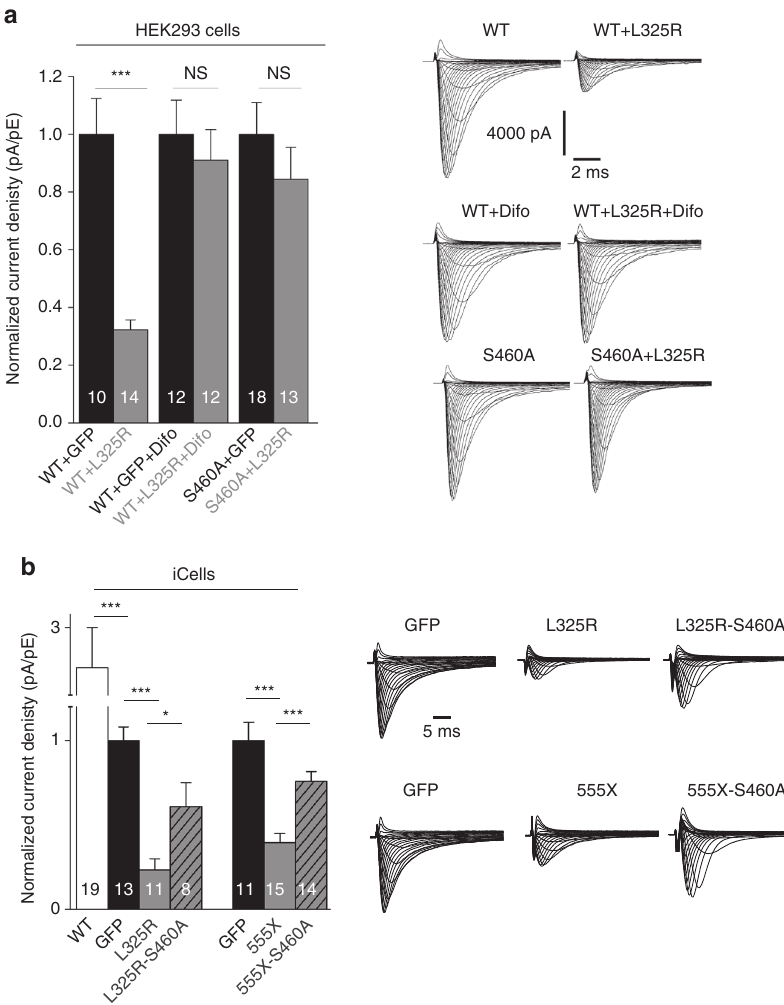
Fig. 3 14-3-3 inhibition abolishes DN effect. a Normalized current density at − 20 mV recorded from transfected HEK293 cells. HEK293 cells were transfected with the different conditions illustrated at the bottom of the graph. WT corresponds to the wild-type cardiac sodium channel, L325R is the DN mutant, difopein (difo) corresponds to a 14-3-3 inhibitor and S460A is a mutant of the sodium channel where the 14-3-3 relevant phosphorylation site (S460) is mutated to alanine. Right panel displays representative family current traces for each conditions. b Normalized current density at − 20 mV recorded from iCells transfected with different DN-mutants, GFP or WT. Transfection conditions are illustrated at the bottom of the graph. Right panel displays GFP normalized representative family current traces. n are noted on the bars, data are presented as mean ± SEM, * p < 0.05, *** p < 0.001, NS